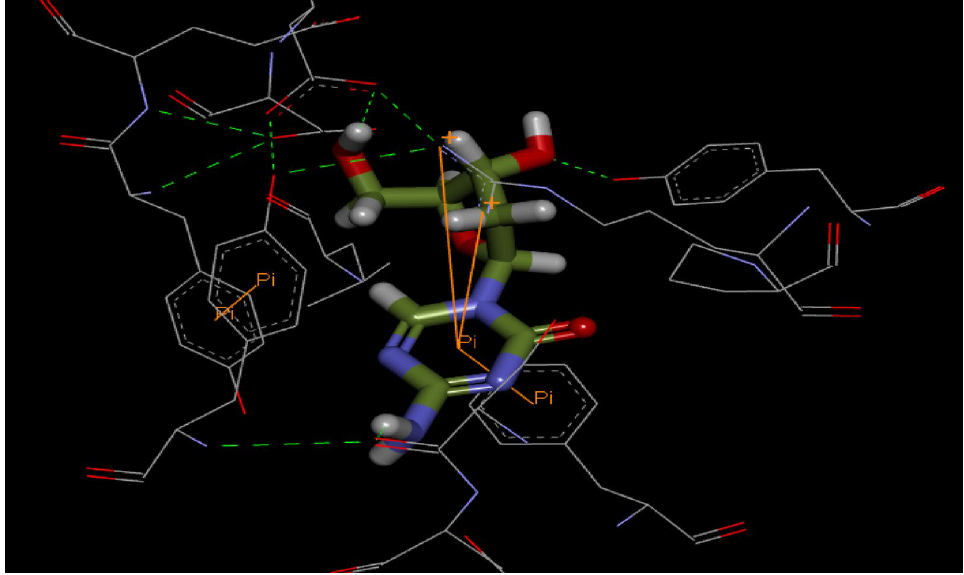
Figure 9. 3D interactions and binding mode of decitabine drug with Thymidylate kinase (Pdb ID: